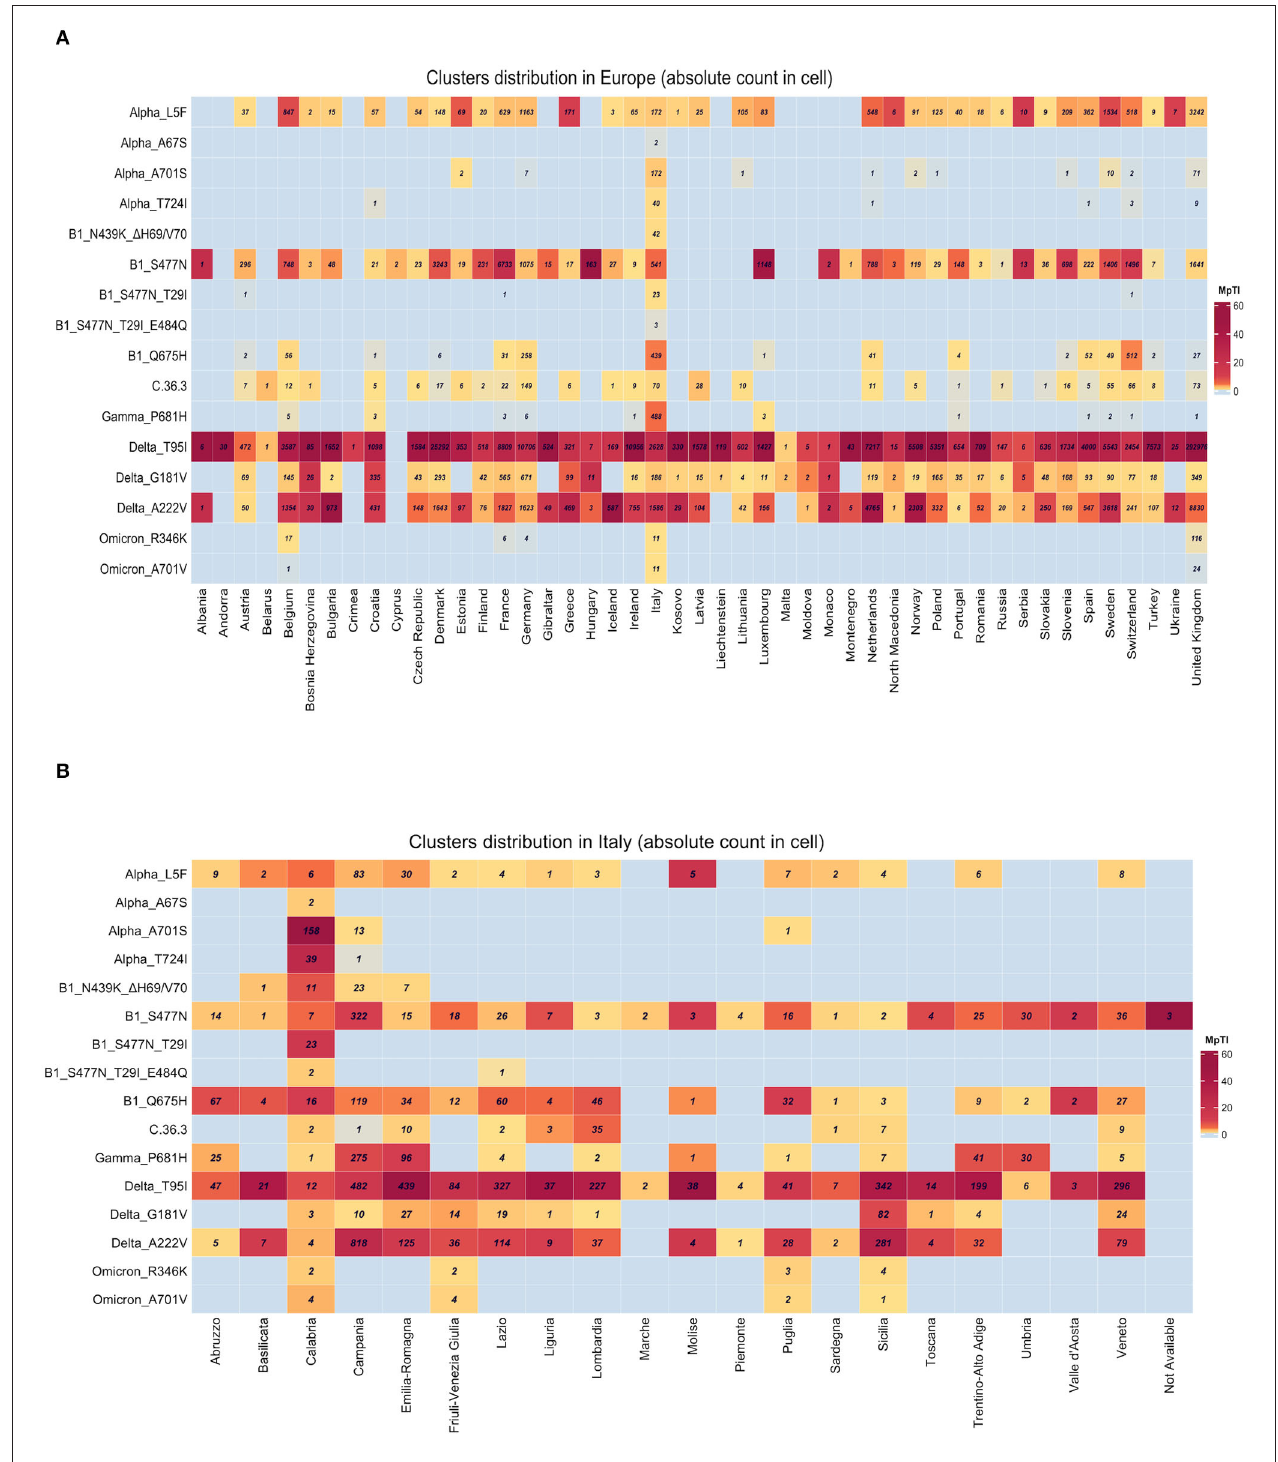
FIGURE 8 | Geographical distribution of the different variants’ sub-genotypes. Heatmaps show the distribution of the different sequences available in GISAID database. Numbers within the boxes represent the absolute numbers of sub-genotypes characterized by the presence of the mutations indicated on the left side among European countries (A) or Italian regions (B) . Variations per Thousand Isolates more than 10 are plotted.